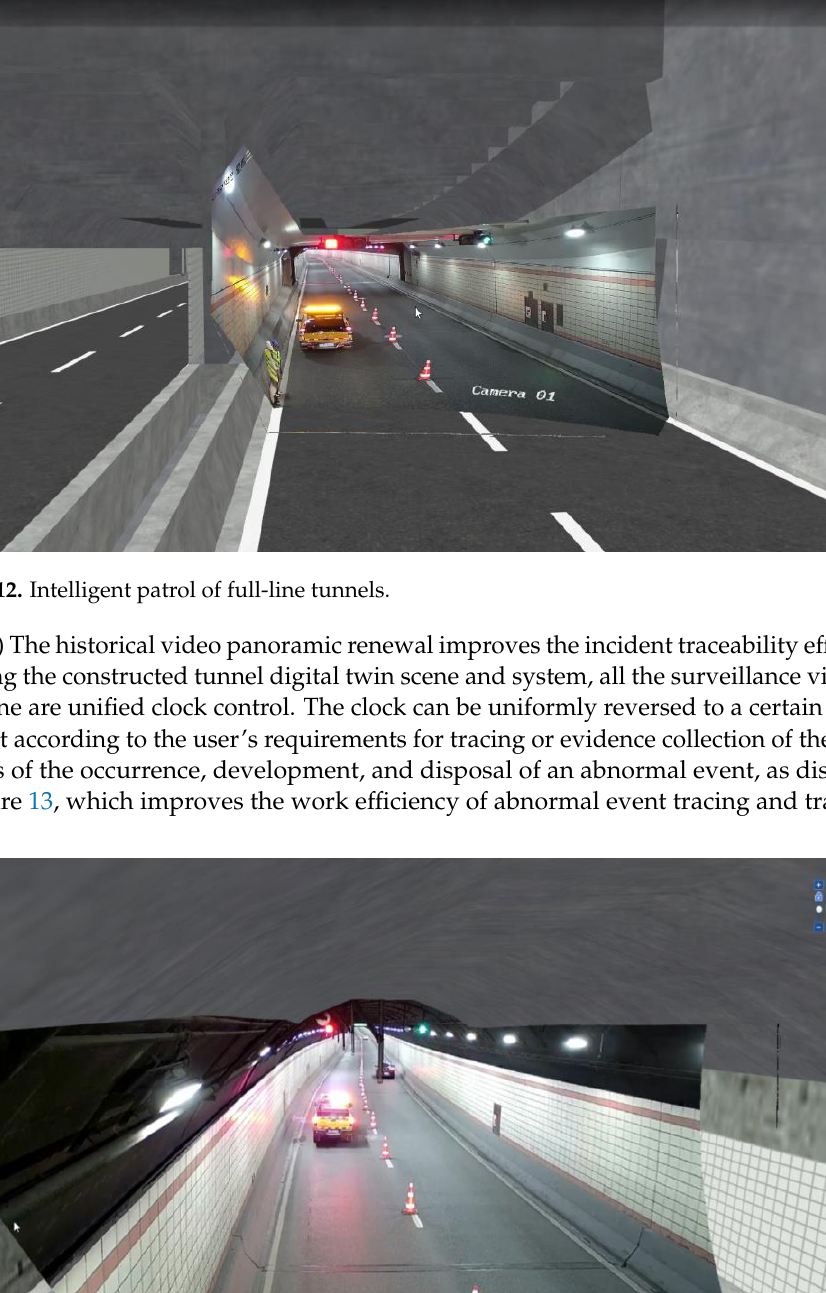
15 of 23 Figure 11. Tunnel virtual top view display.